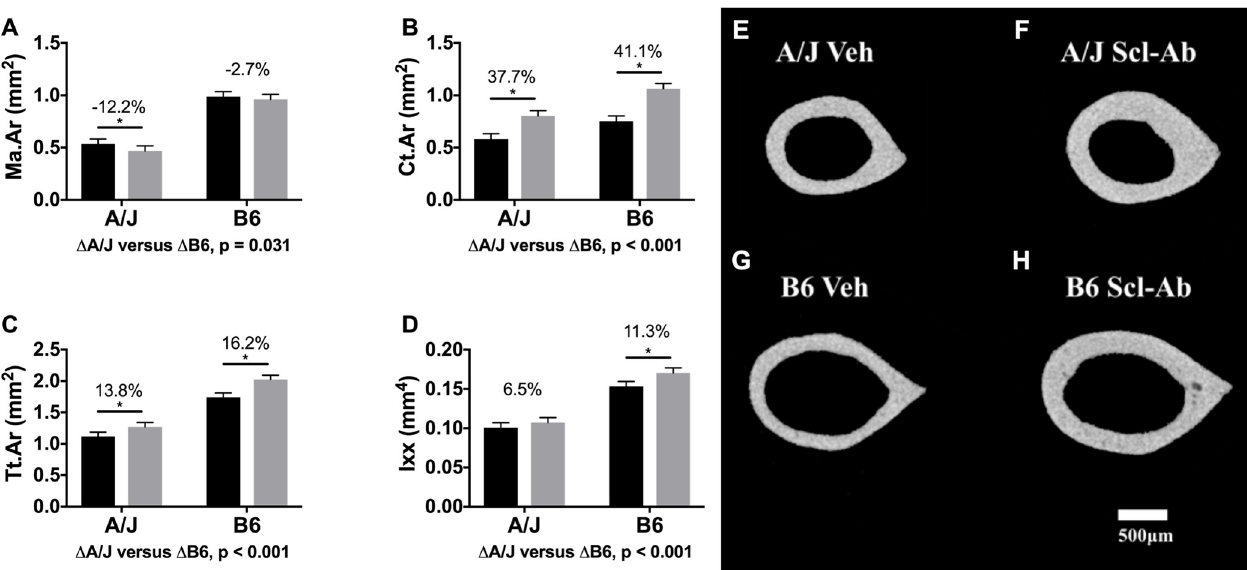
Fig 4. Morphological data derived from the femoral diaphysis. Data showed that Ct.Ar (A) and Tt.Ar (B) were similarly significantly greater in A/J and B6 femurs, while Ma.Ar (C) was significantly smaller only in A/J femurs with treatment. Moment of inertia (D) was significantly greater with Scl-Ab administration in both strains, but the magnitude of this change was significantly greater in B6 than A/J. Main effects by strain and treatment as well as the interaction of strain by treatment were tested using an ANOVA. Percent changes were calculated from least square mean differences of Tukey pairwise comparisons (p < 0.05). Representative nanoCT images of mid-diaphyseal cortical bone for treated and control A/J and B6 mice are shown in Fig 4E–4H. Black bars = Vehicle and gray bars = Scl-Ab treated.